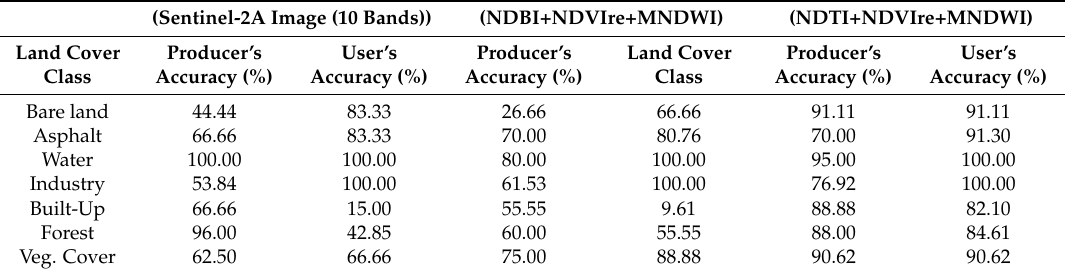
Table A5. Classification accuracies of different approaches for Figure 10.